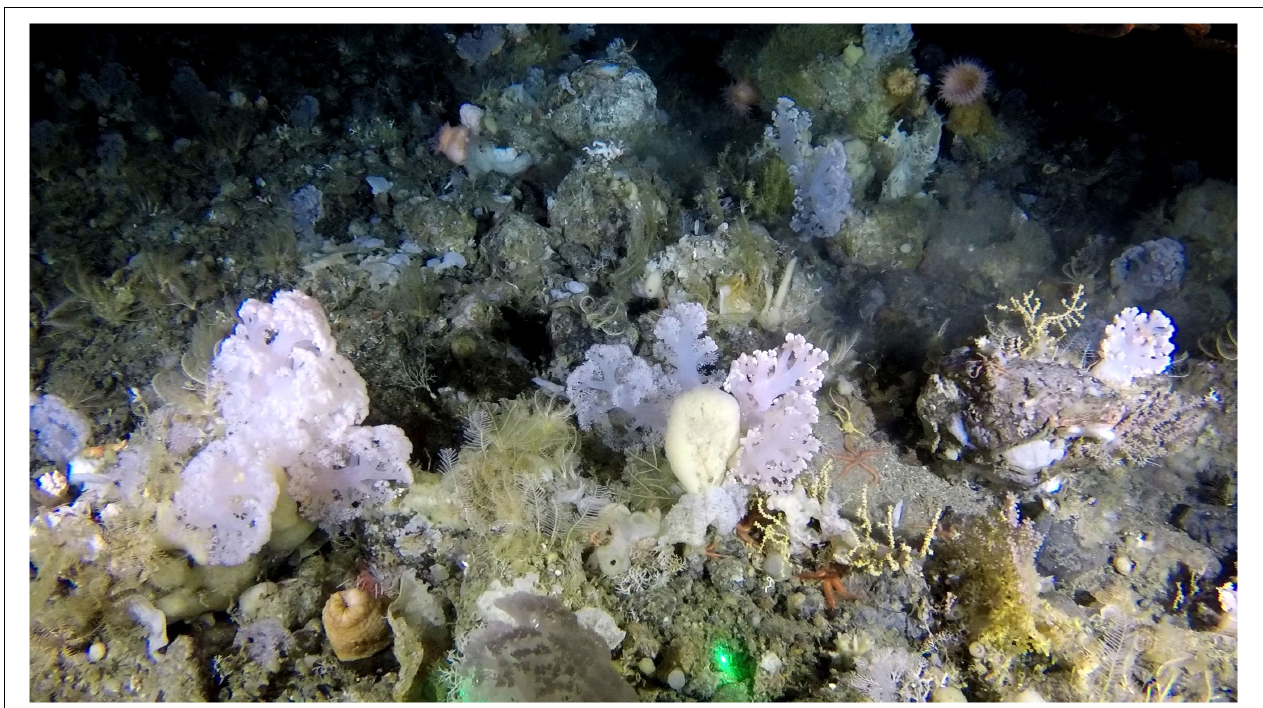
FIGURE 10 | Example still showing the structural complexity of the soft coral garden habitat, from Station 2018_SA_11_087, at a depth of 585 m, on the continental slope of Toqqusaq Bank, west Greenland. Cauliflower corals, feather stars, gorgonians, sponges, anemones, brittle stars, hydrozoans, and calcified bryozoans, are present. Laser dots (green) are 20 cm apart; the left hand dot is partially